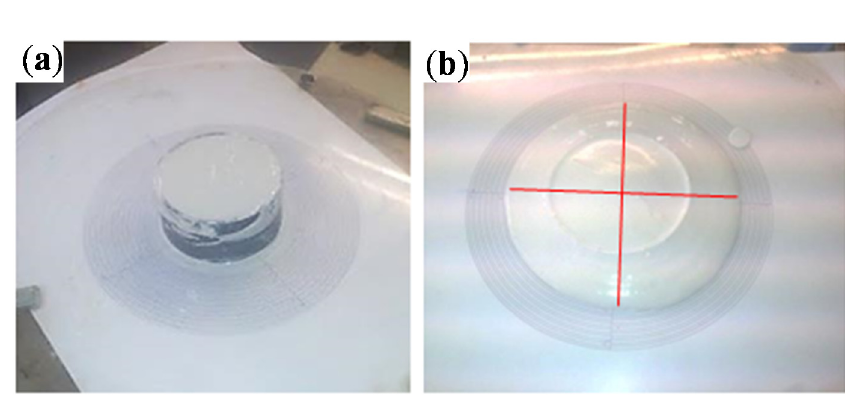
Figure 1. ( a ) Starting the flow value test; ( b ) after the run-off of the gypsum.